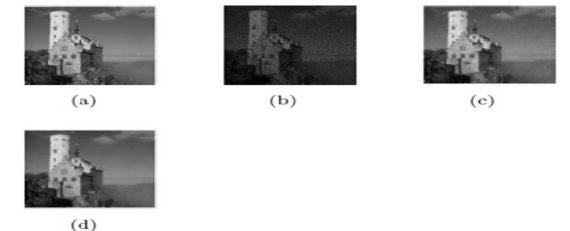
Fig. 3: Obtained Results on House Image; (a) True Image; (c) House Corrupted with Multiplicative Noise L 1 = 0.09; (c) Reconstructed Image Using M1 ( λ = 437); (d) Reconstructed Image Using M2 ( λ = 346, c = 1.72)